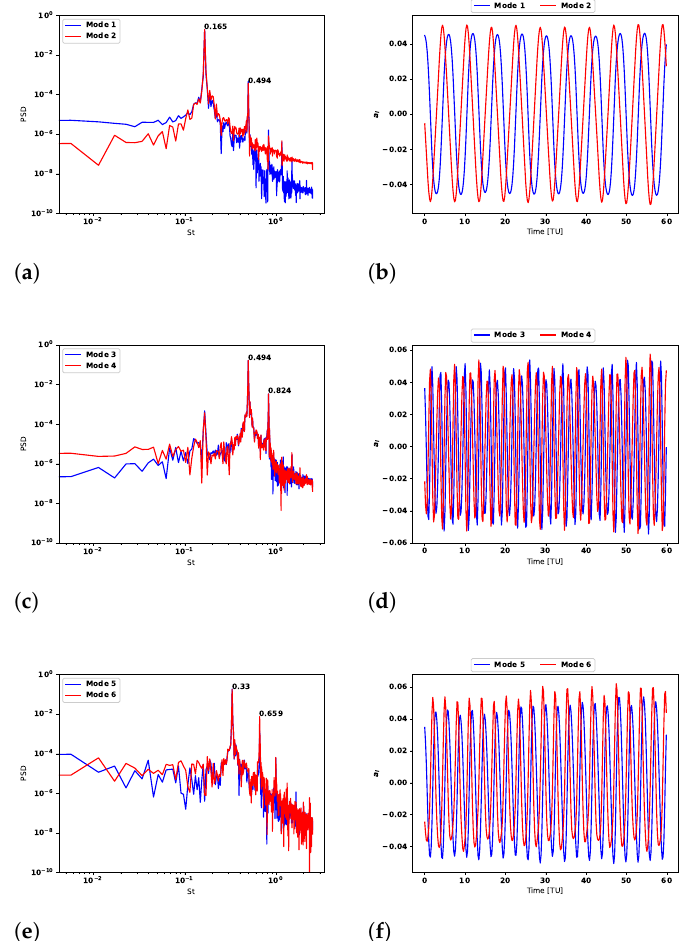
Figure 9. Energy spectra ( a , c , e ) and the first 60 TU of the time coefficients ( b , d , f ) of each of the three pairs of modes: 1–2, 3–4, and 5–6,